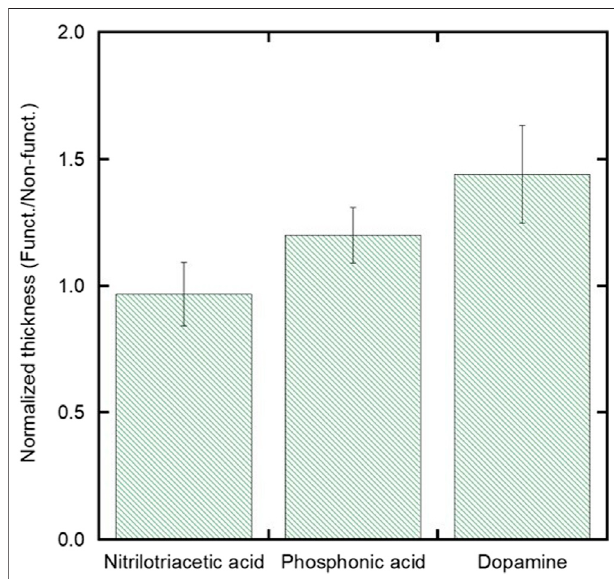
FIGURE 6 | Plot showing the normalized thicknesses (de fi ned as the average functionalized thickness divided by the average non-functionalized thickness) comparing the fi lms that were both non-functionalized and functionalized with NTA, PA, or DPA for the low particle concentration and moderate fi eld condition.